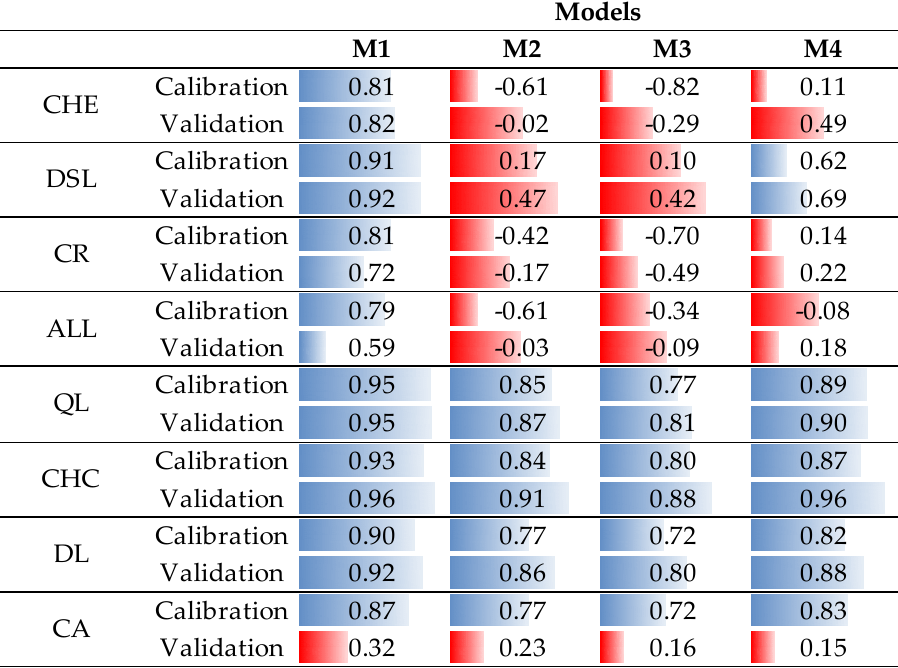
Table 3. Model performance in the calibration and validation periods. The blue bars represent behavioral models (LOG NSE > 0.5) and the red bars non-behavioral models.